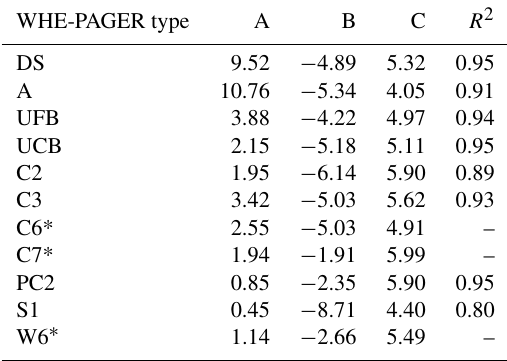
Table A1. Fragility coefficients.